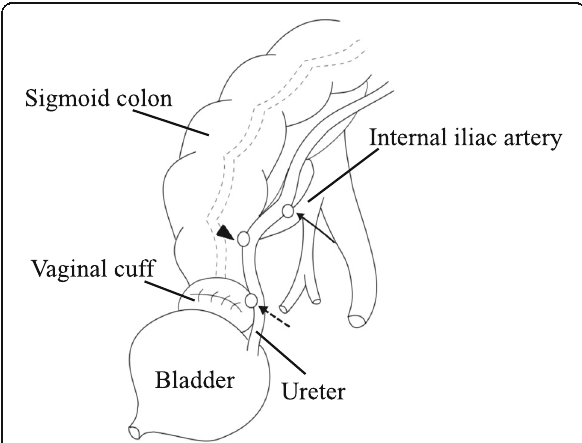
Fig. 3 An autopsy revealed a newly developed fistula between the left ureter and iliac artery branch (arrow). Bleeding from this site might have spread out to the extracorporeal space through the pre- existing uretero-colic (arrowhead) and uretero-vaginal fistulas (dotted arrow)